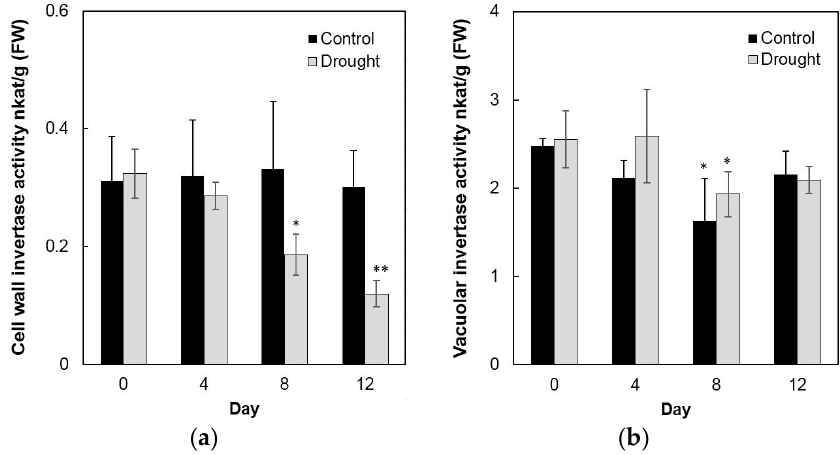
Figure 8. Effect of drought stress on cell wall invertase activities (a ) and vacuolar invertase activities ( b ) in the maize sink part of the leaf. Data represents mean ± SE of at least four independent biological replicates. Asterisks indicate significant differences in comparison with the control of 0 day by using a Student’s t -test: * p < 0.05, ** p < 0.01.